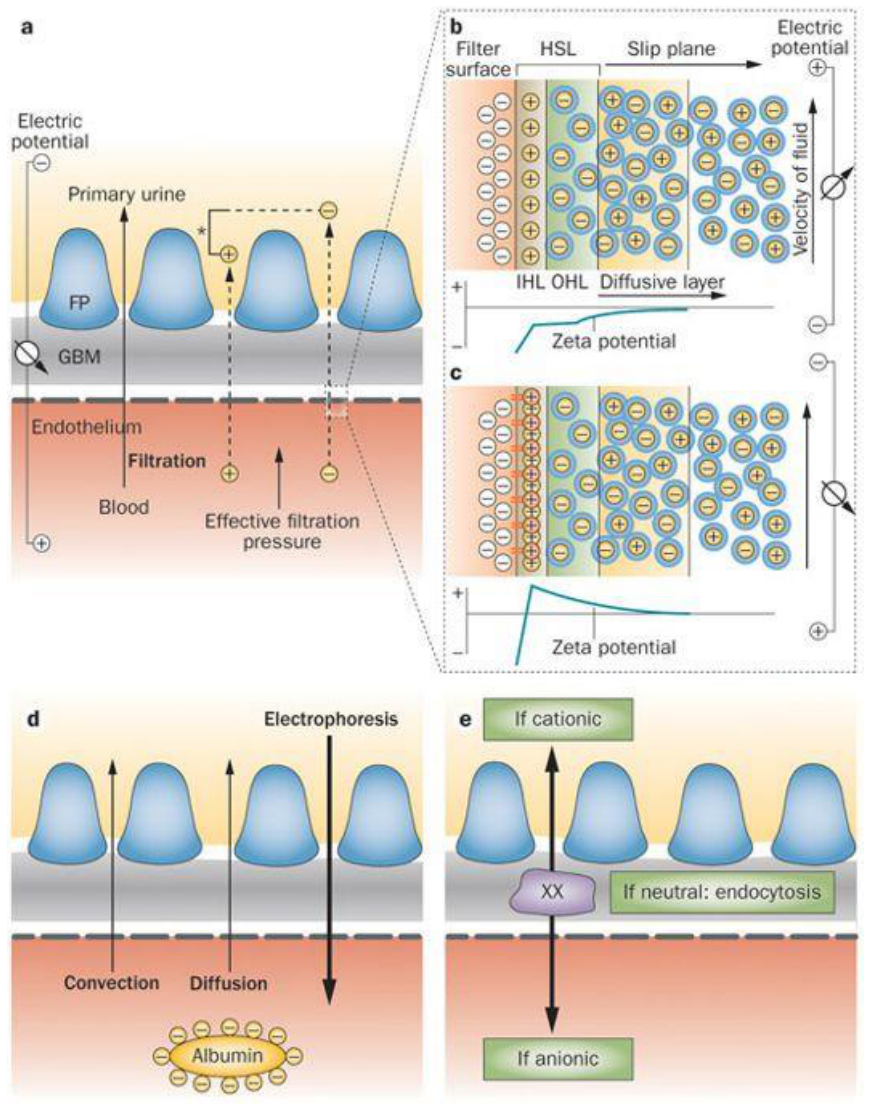
Figure 1. The human body waste filtration at a glomerular-based membrane: ( a ) the ultrafiltration in a glomerular-based membrane consisted of a two-pore model (contact) and electro-kinetic model (contactless), ( b,c ) the electrical model for an active filtration by electrophoresis, ( d ) the mechanism of passive filtration by convection, diffusion and active filtration by electrophoresis and ( e ) the anti-clogging for selective detection and rapid manipulation [19].